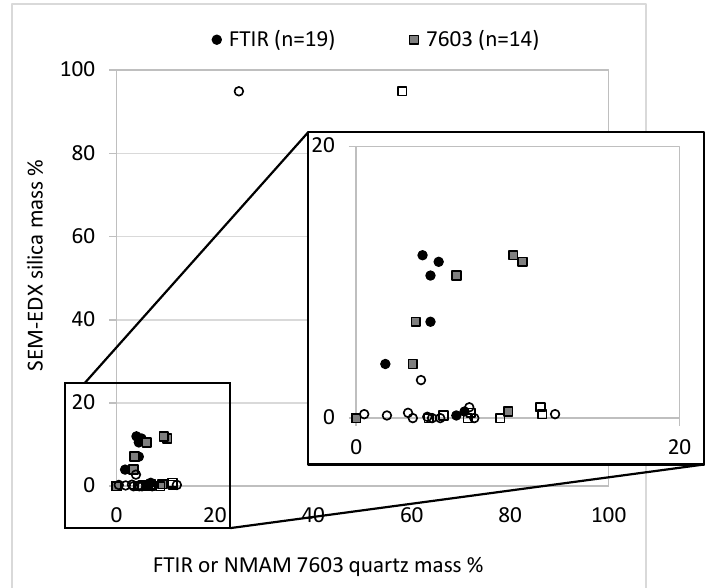
Figure 4. Distribution of silica mass% estimated from SEM-EDX for the RCMD samples, with plots shown by mine region for each sampling location. In ( a ) high-PLD samples are excluded, in ( b ) all samples are included regardless of PLD.